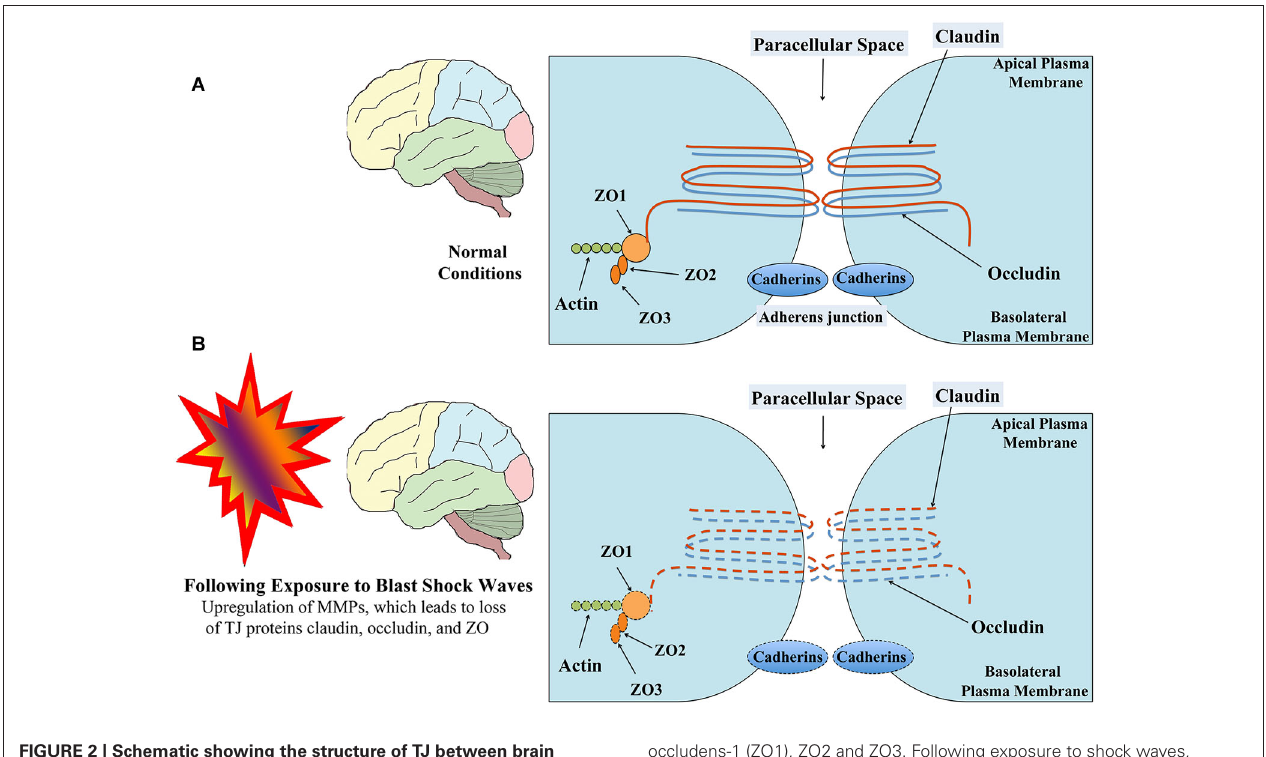
FIGURE 2 | Schematic showing the structure of TJ between brain endothelial cells in normal conditions (A) and following exposure to low-intensity BSWs (B) . TJs mainly comprise trans-membrane proteins claudin and occuldin anchored to cytoplasmic proteins zona